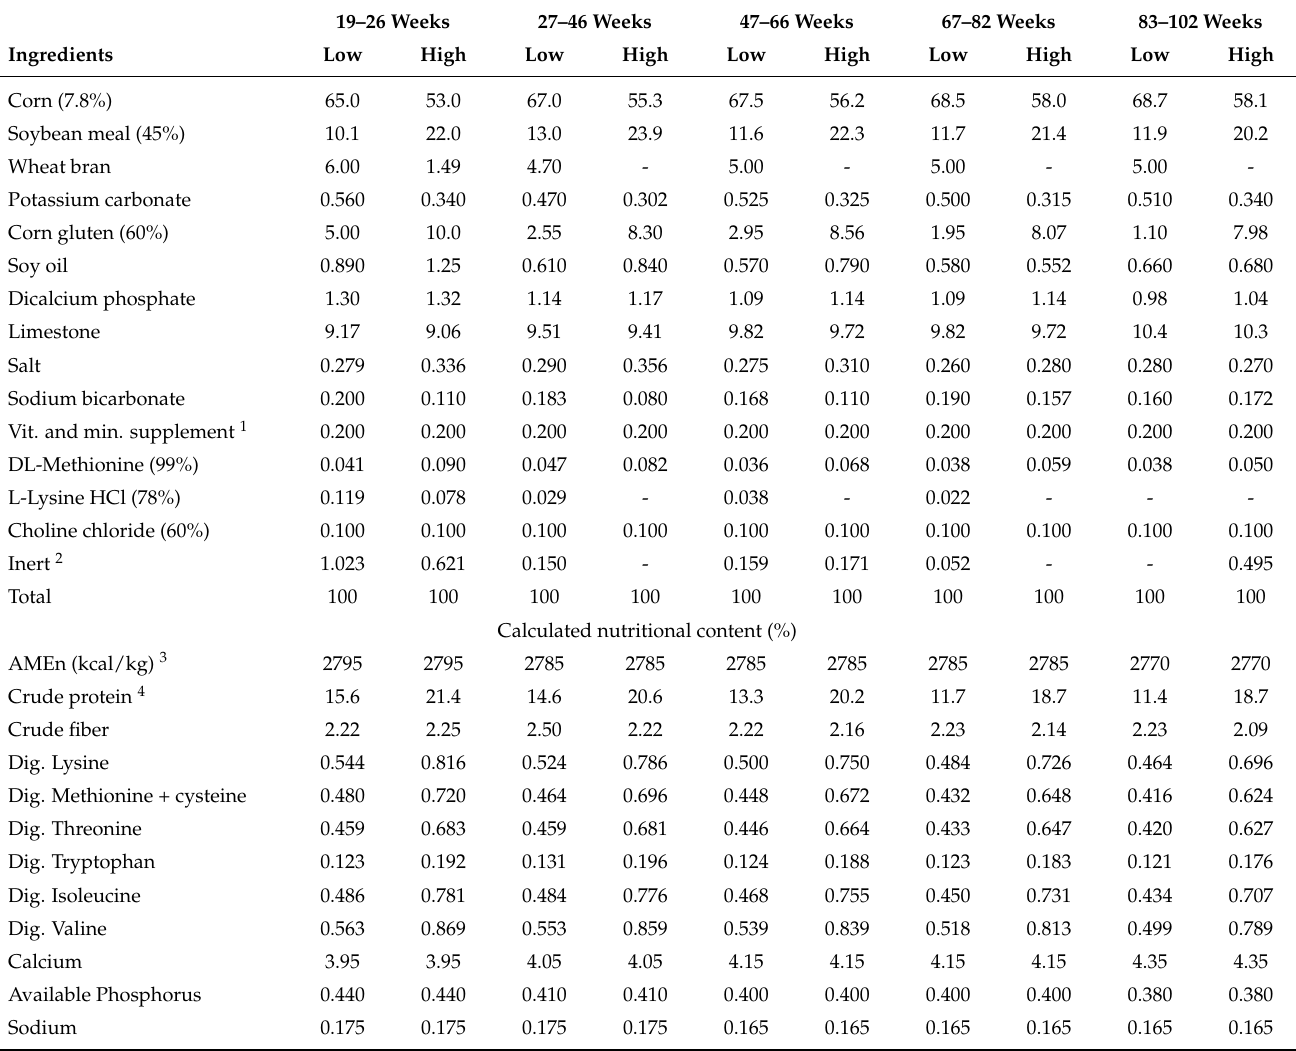
Table 2. Composition and calculated nutritional content of low and high dietary balanced protein feeds in the laying